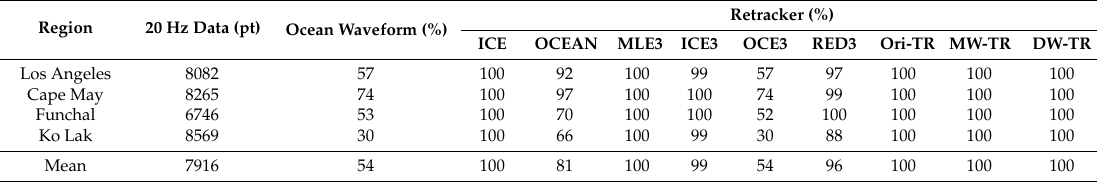
Table 2. Data availability of various retrackers within 10 km offshore in each study region.